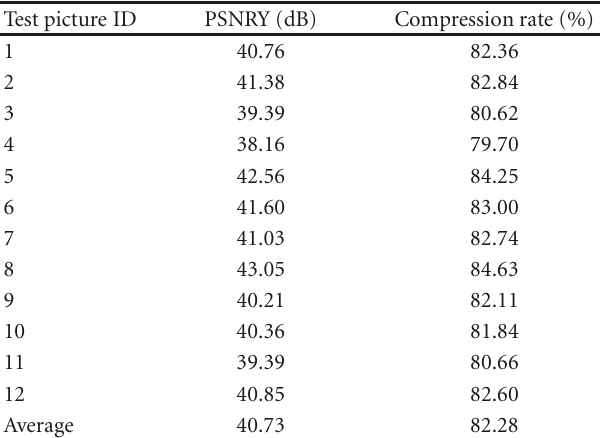
Table 4: The simulation results of twelve tested